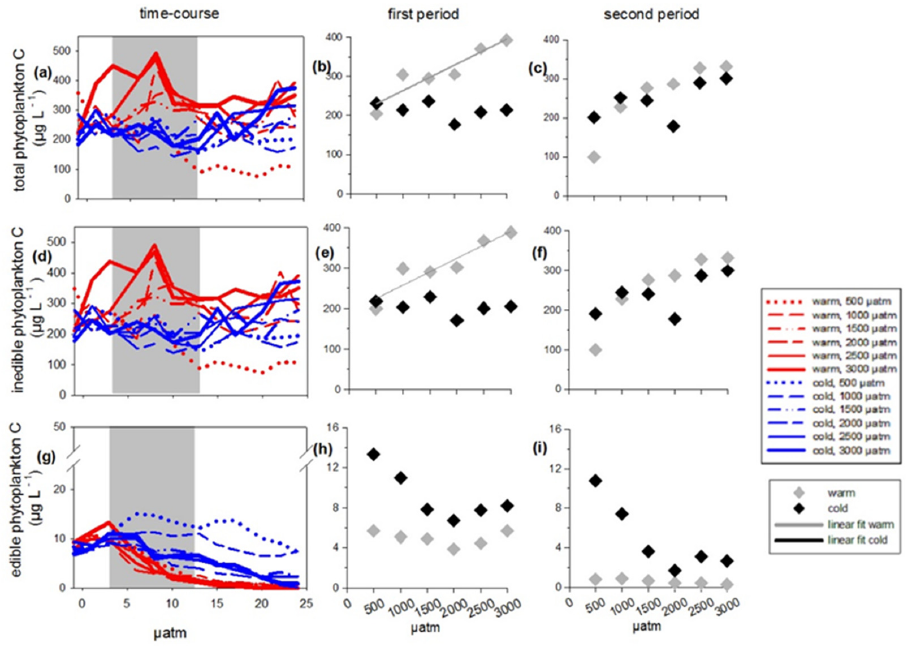
Figure 2. Phytoplankton carbon ( μ g C L − 1 ) over the entire course of time and as mean values of the first and the second period. The first period, during which a bloom in the warm treatments occurred, is marked in grey color in the subpanels ( a , d , g ). ( a – c ) Total phytoplankton carbon, ( d – f ) inedible phy- toplankton carbon, ( g – i ) edible phytoplankton carbon. Symbol attribution to treatment combinations (temperature treats + CO 2 target values) are given in the legend. Fitted lines indicate a significant response of phytoplankton relative contribution to CO 2 at the different temperature